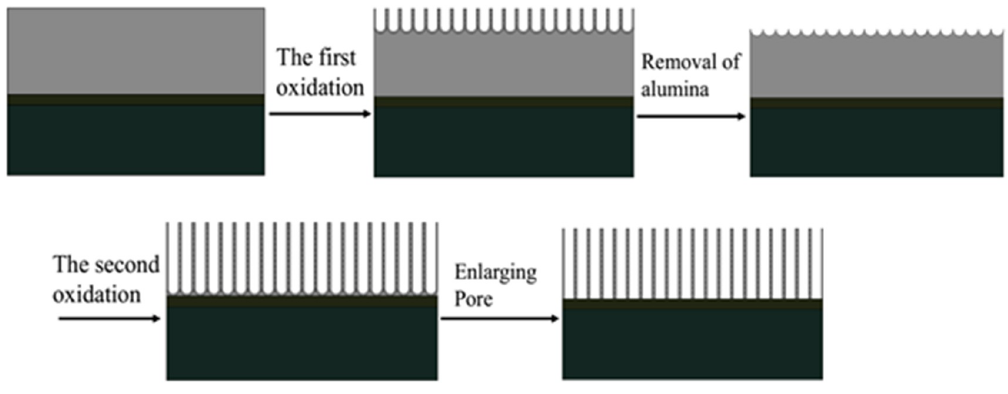
Figure 4. Schematic diagram of the anodizing process.